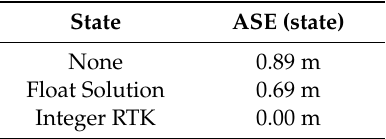
Table 2. Calculated ASE values for each calibration